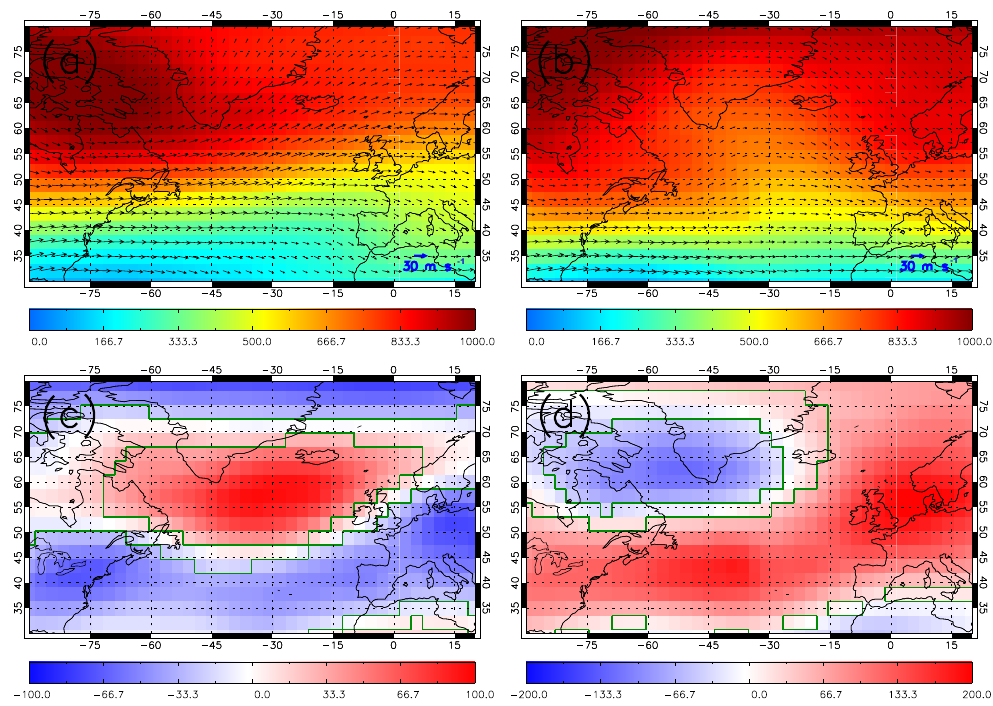
Figure 13. TOMCAT ozone (ppbv) averaged between 200 and 100hPa for 2006–2015 sampled under the wintertime (NDJF) NAO. Panel (a) NAO positive phase, (b) NAO negative phase, (c) represents the NAO positive phase anomaly relative to the wintertime average and (d) represents the negative NAO phase anomaly relative to the wintertime average. Wind vectors show the horizontal 200–100hPa winds. Green polygon-outlined regions in (c) and (d) highlight significant differences at the 95% confidence level based on the